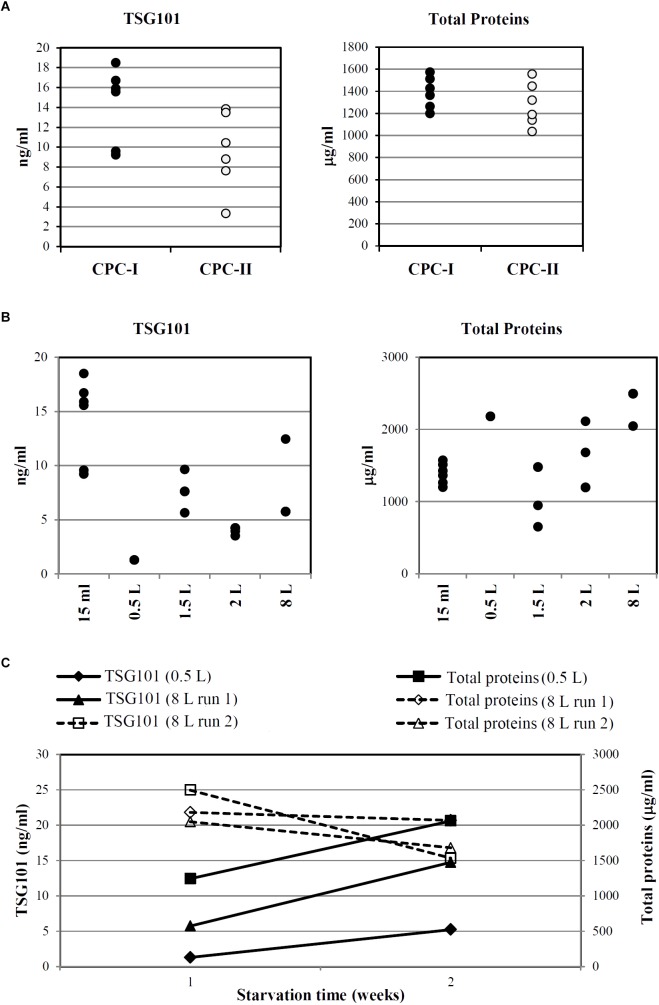
Optimization and scale-up of Exo-CPC production. (A) TSG101 content and total protein content in CM from CPC-I and -II. Production scale: 15 ml; cells starved for 7 days before medium collection. Each dot represents the analyte concentration in CM from a single culture. (B) TSG101 content and total protein content in CM from CPC-I on different culture volumes; cells starved for 7 days before medium collection. Each dot represents the analyte concentration in CM from a single culture. (C) Time course of TSG101 and total protein content in CM collected from CPC-I at 1 week (7 ± 1 days) and 2 weeks (14 ± 1 days) during starvation. Production scale: 0.5 and 8 l. Paired Student’s t-test at 2 weeks versus 1 week starvation: p < 0.05 for TSG101 content, not significant for total proteins content.